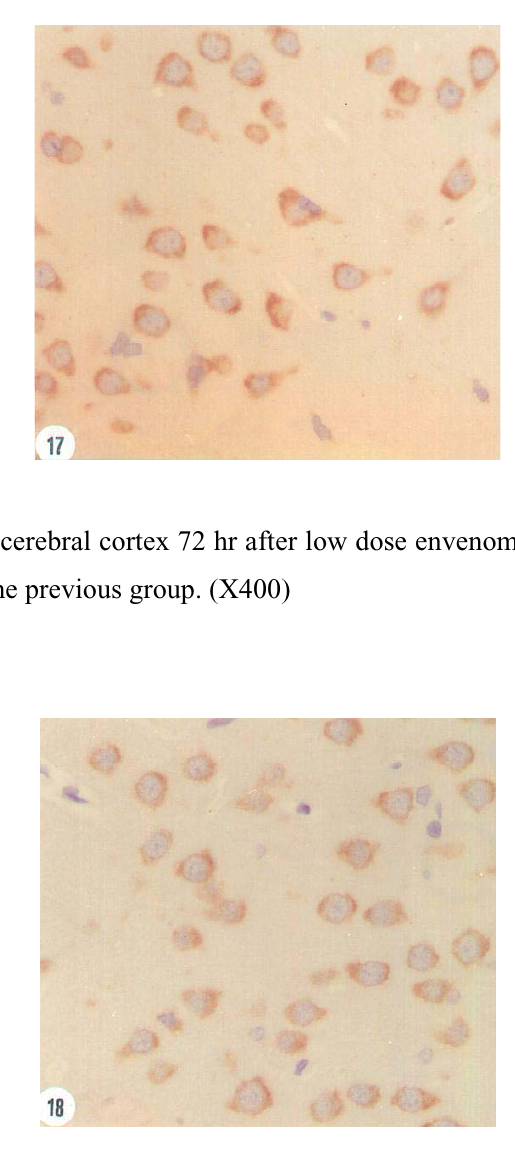
Figure 18. Decreased Bcl-2 reactivity after 24 hr after high dose envenoming.